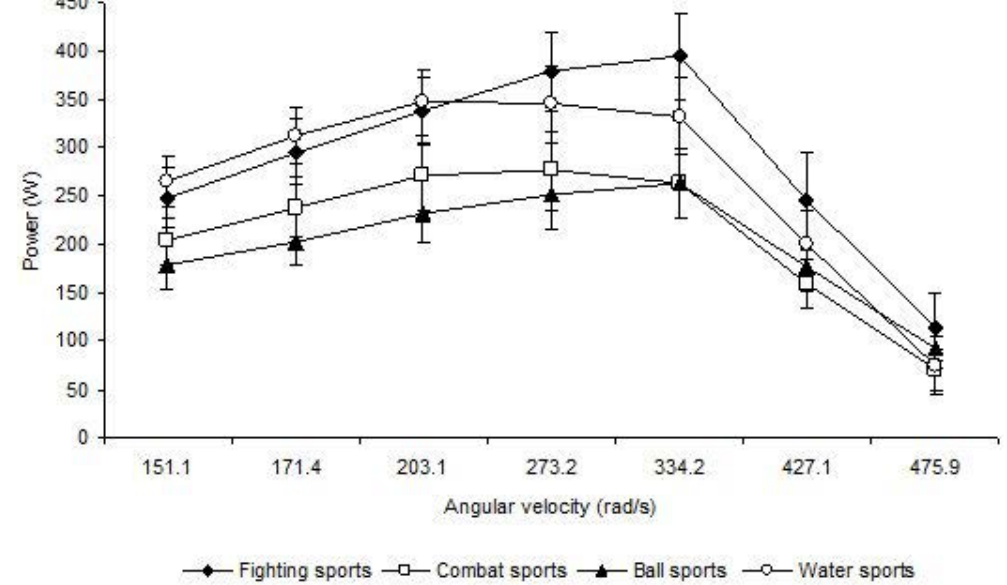
Figure 3. Power during trunk rotations across different velocities in ball, combat, fighting and water sports athletes.